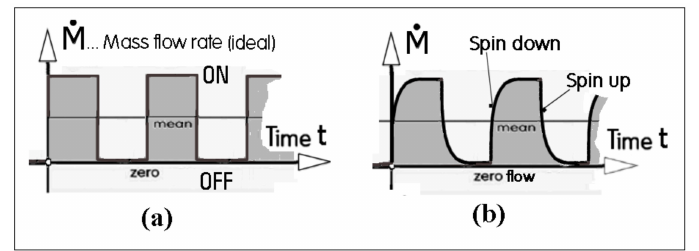
Figure 1. Schematic presentation of oscilloscope traces of pulsating flow with ( a ) ideally shaped rectangular pulses and ( b ) characteristic pulse shapes generated by the captive vortex devices.